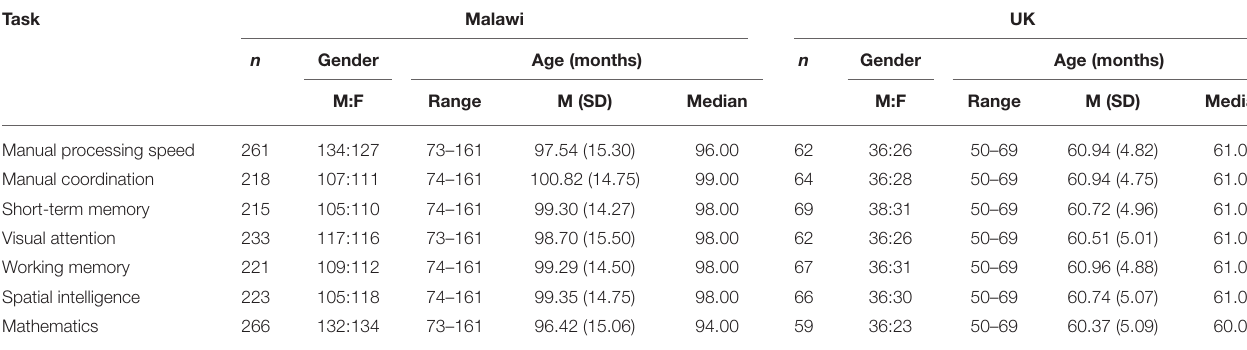
TABLE 1 | Structure of the Malawi and UK samples for each